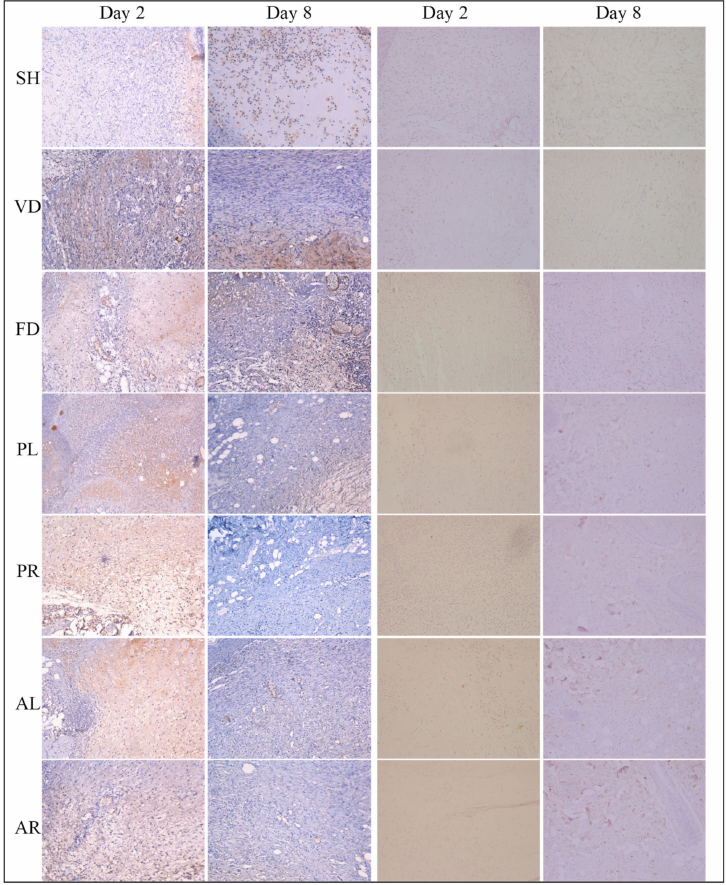
Figure 7. Photomicrographs of wounded skin tissue immunostained with an antibody against collagen-III (10 × magnification) and collagen-I (10 × magnification) in seven male rat experimental groups: SH, VD, FD, PL, PR, AL, and AR. Brown staining in the first and second columns indicates collagen-III deposition and the third and fourth columns indicate collagen-I transformation. SH: sham control group (without treatment); VD: treated with vehicle (Cetomacrogol ointment); FD: treated with flavine (Acriflavine 0.1%); PL: treated with 1.0% concentration of MPvp leaves extract; PR: treated with 1.0% concentration of MPvp stem roots extract; AL: treated with 2.0% concentration of MPva leaves extract; AR: treated with 2.0% concentration of MPva stem roots extract. Bar scale: 50 µ